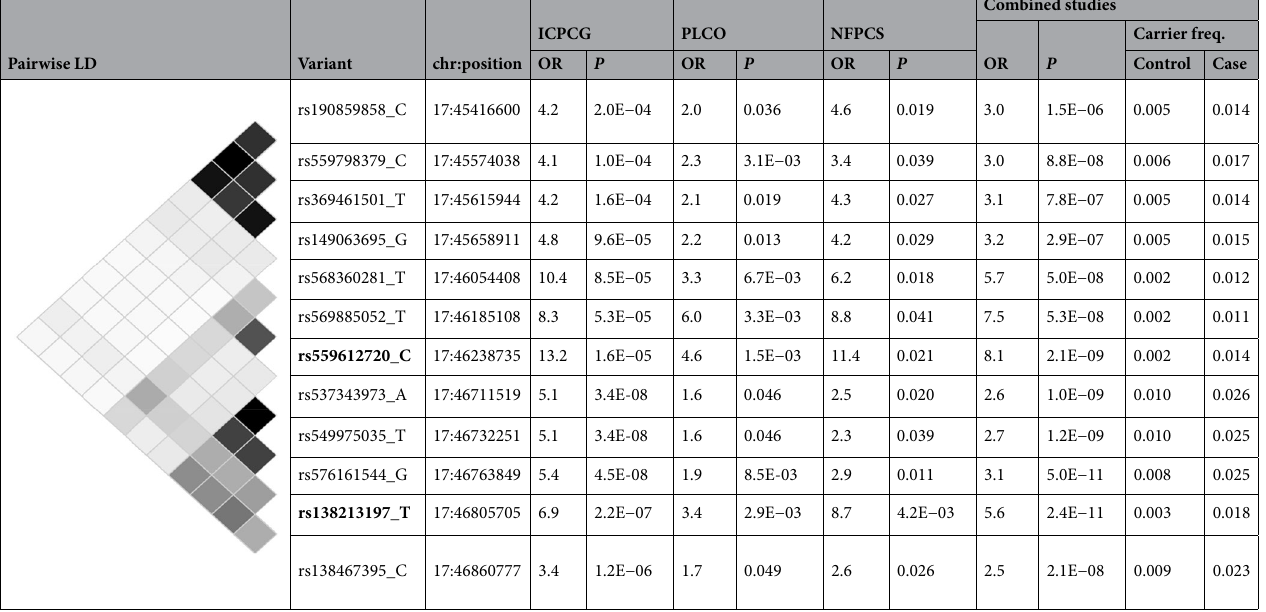
Table 2. Prostate cancer risk alleles of the HOXB locus. Linkage disequilibrium (LD) is depicted for controls (greyscale, R 2 = 1 in black and R 2 = 0 in white). Results for each study population are presented for models regressing cancer status against a given variant with adjustment for the first ten principal components of genetic ancestry. Bold font designates sentinels best detecting independent risk signals. The HOXB13 G84E variant is